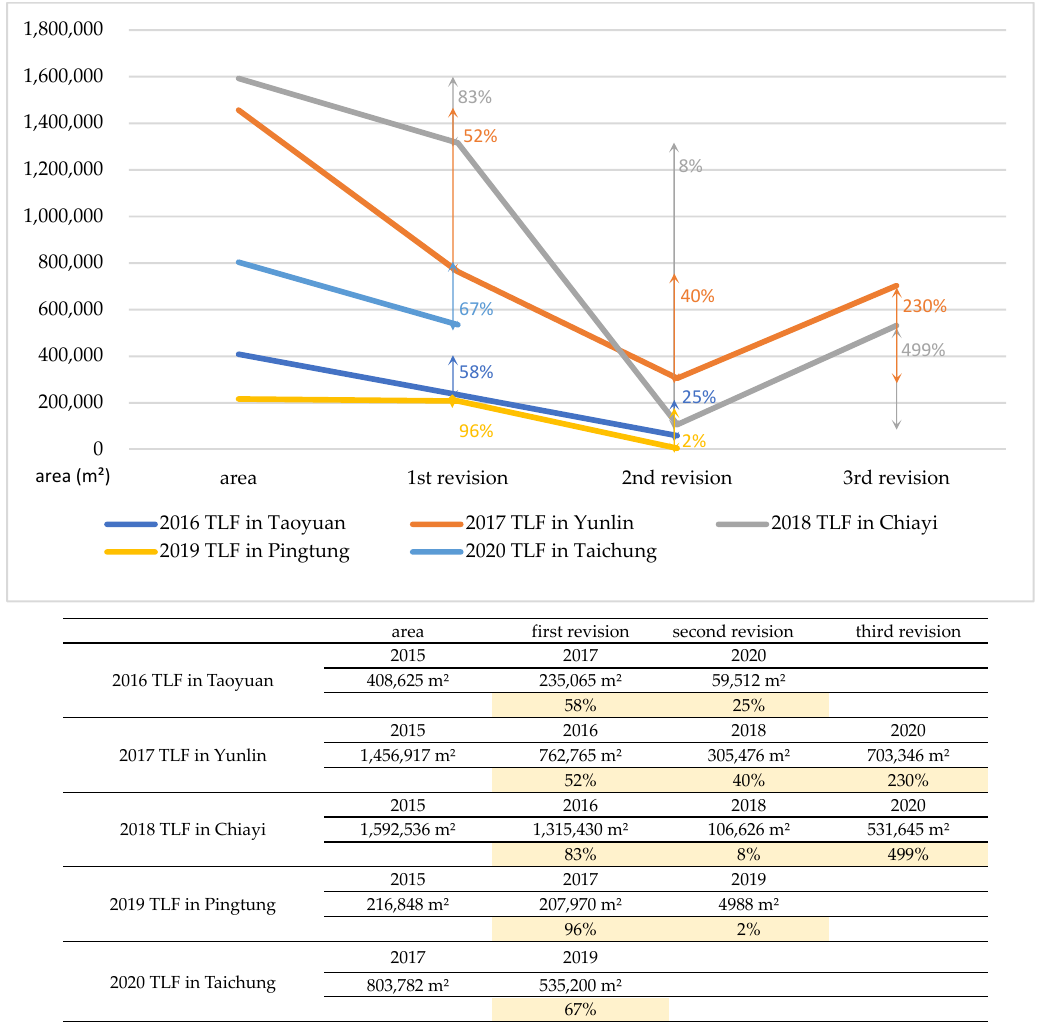
Figure 6. Yearly revision of TLF sites by total area and percentage.